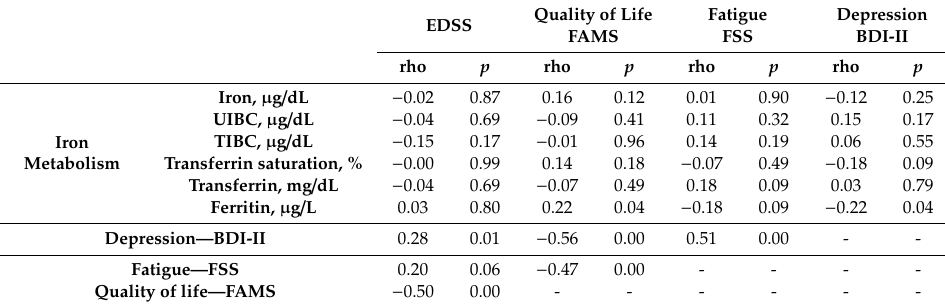
Table 3. Spearman rank correlations between the analysed